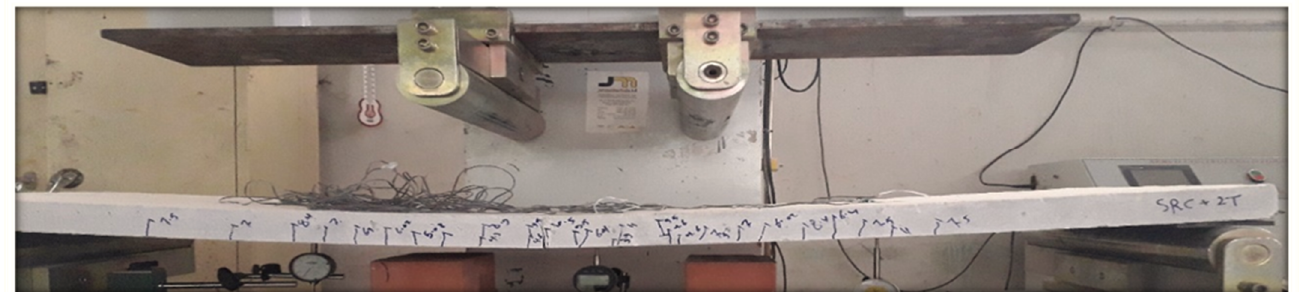
Figure 15. Failure of SRC + 1T tested slab.